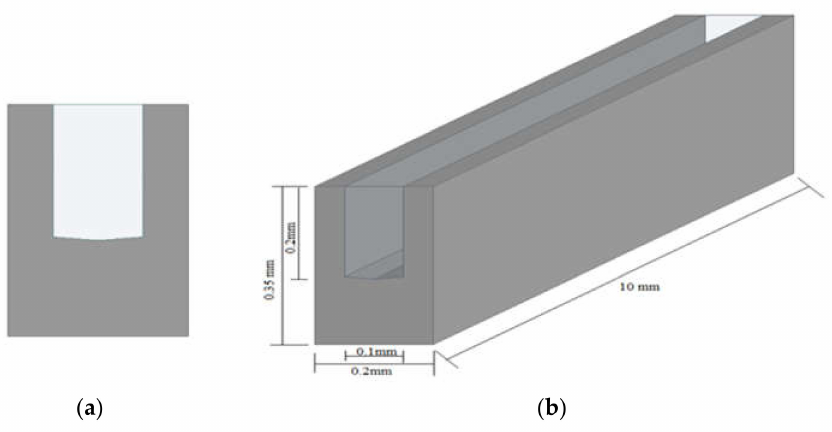
Figure 1. Dimensional computational domain of single microchannel: ( a ) cross-sectional view, ( b ) isometric